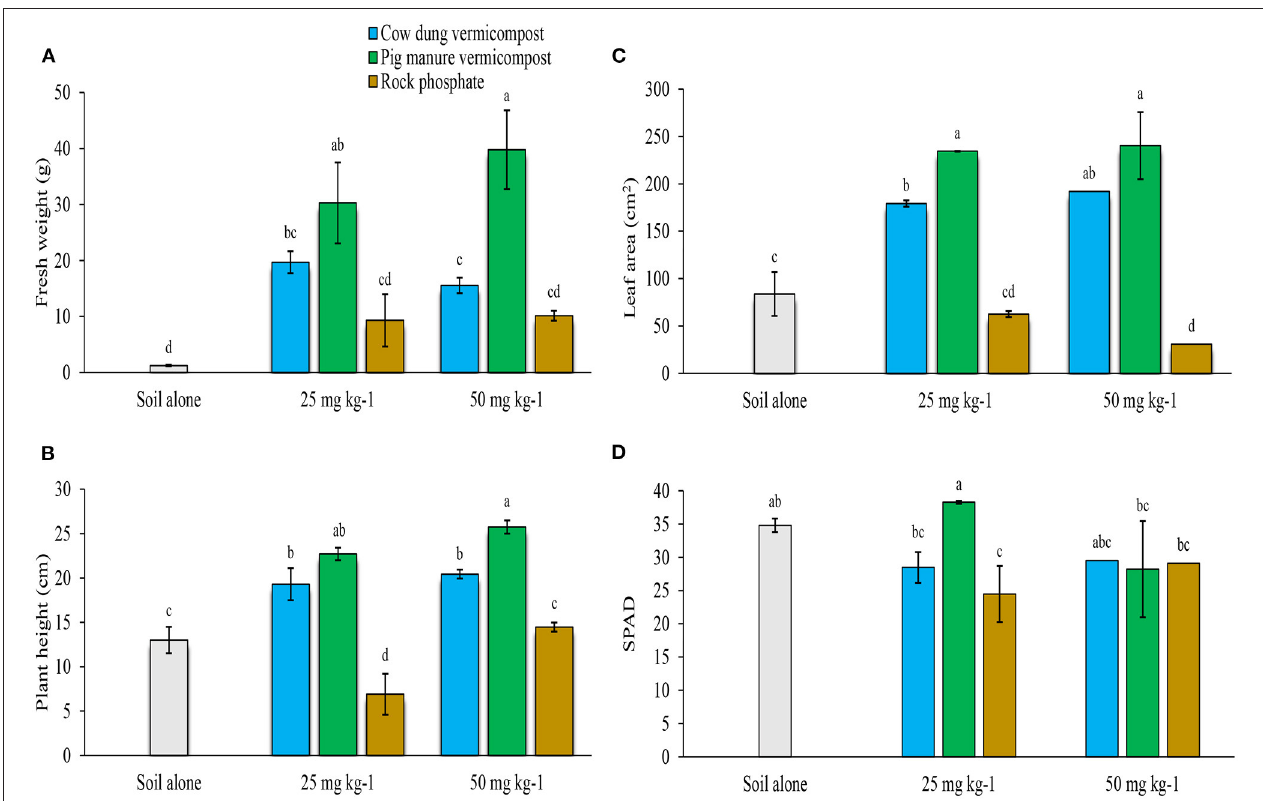
FIGURE 1 | The fresh weight (A) , plant height (B) , leaf area (C) , and SPAD (D) content of Swiss chard tissue at week 8 after transplanting using Oxisol soil that has been incorporated with P as RP-enriched cow and pig manure vermicompost at a different level. Error bars represent standard deviations, and significantly different numbers for the same parameter are followed by different letters based on LSD ( p ≤